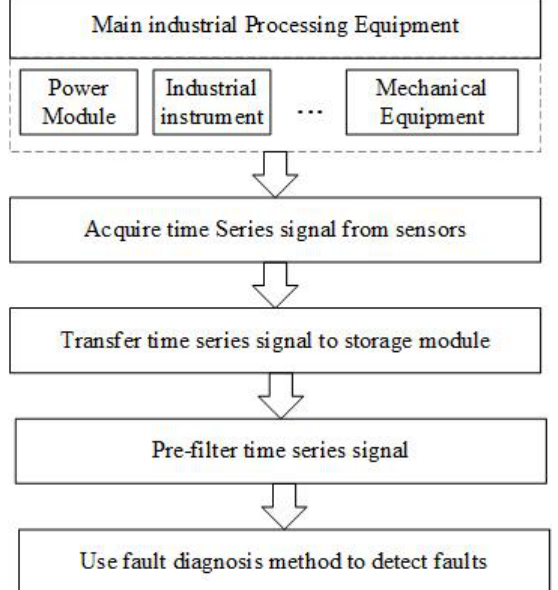
Figure 2. Flow chart of diagnosing